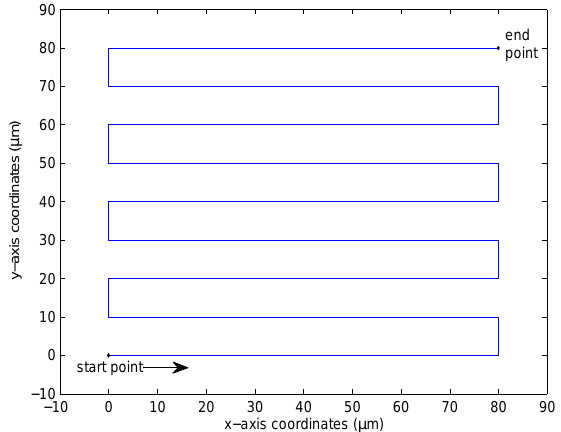
Figure 15. Trajectory of data acquisition for model